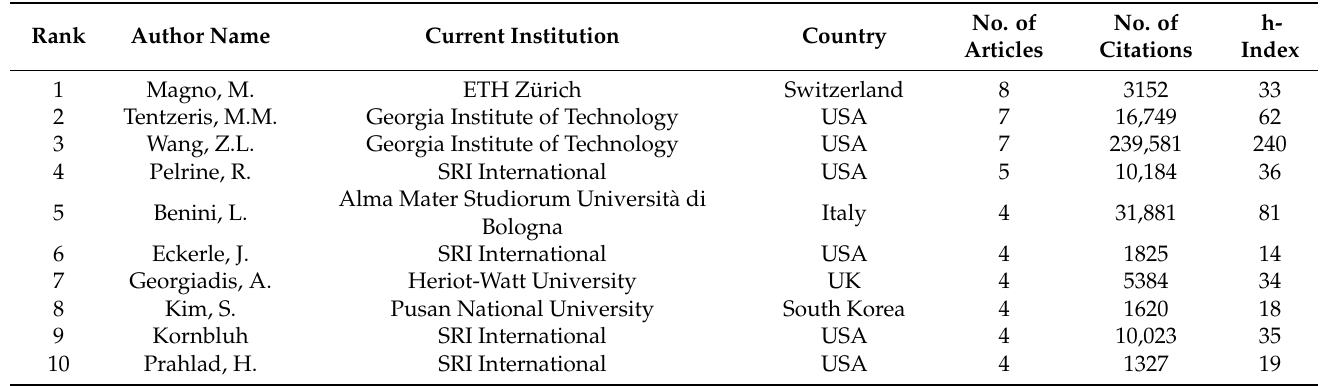
Table 4. Top 10 authors with the highest number of manuscripts in this area.